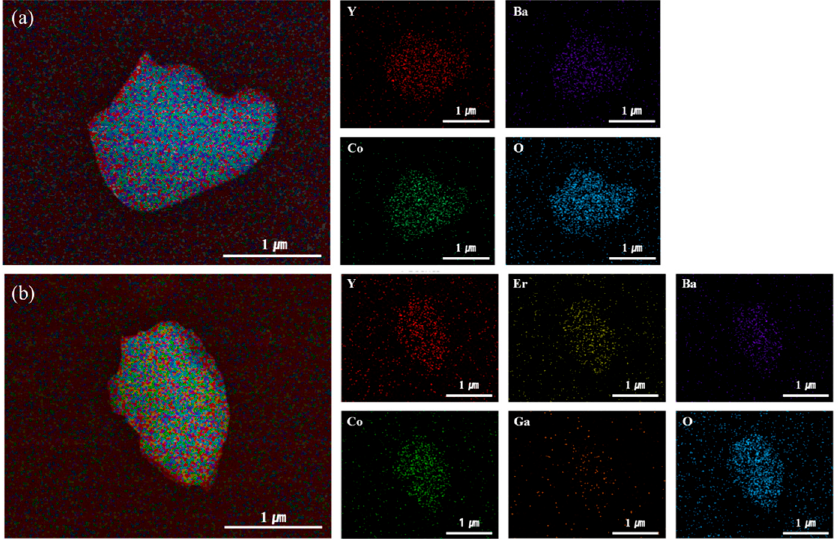
Figure 3. Elemental mapping images of ( a ) Li[YBC] and ( b ) Li[YEBCG] analyzed by EDS.